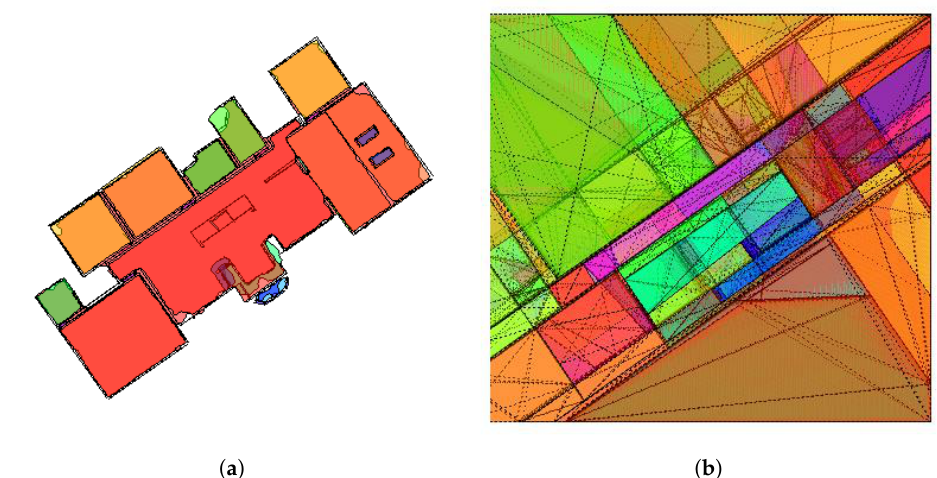
Figure 5. Top view of ( a ) piece-wise planar segments and ( b ) 3D cell complex of our dataset A1. Algorithm 1 3D cell complex construction